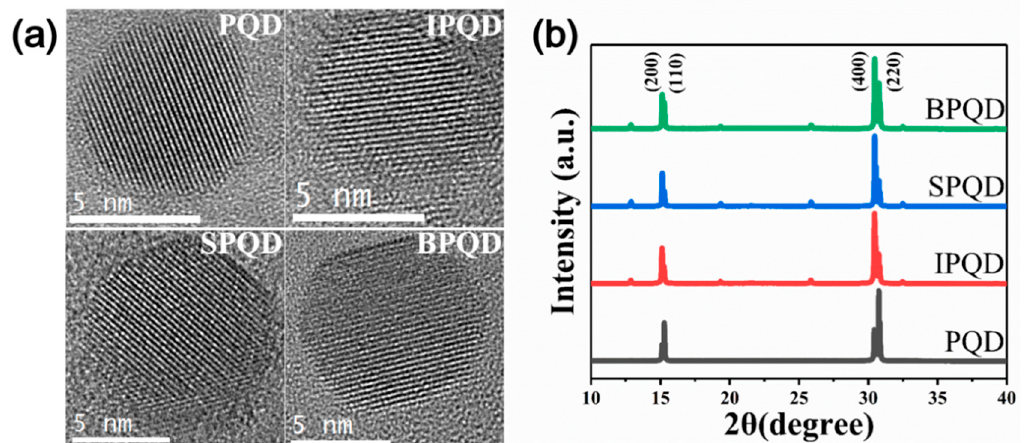
Figure 1. ( a ) High-resolution transmission electron microscopy (HR-TEM) images ( b ) X-ray diffraction (XRD) data of CsPbBr 3 via ligand-assisted re-precipitation (LARP) method. Characterization of trivalent ion substituted CdPbBr 3 perovskite quantum dots (QDs).